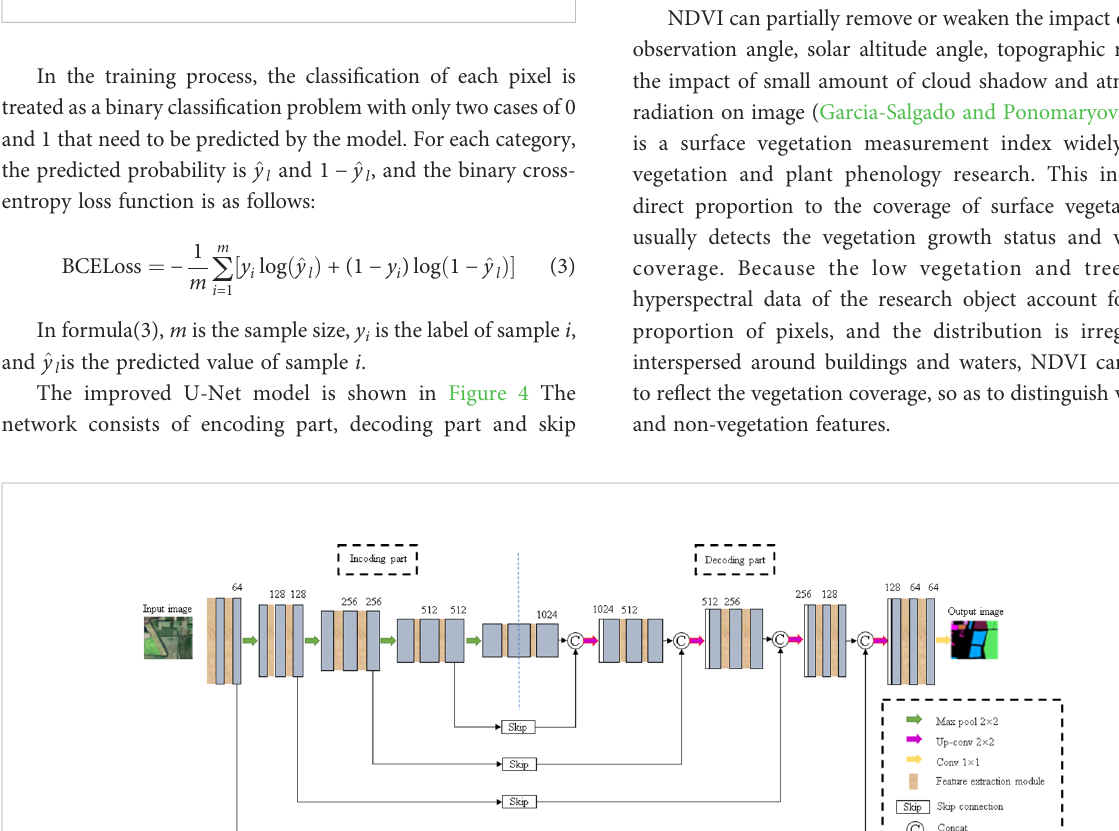
FIGURE 3 Feature extraction